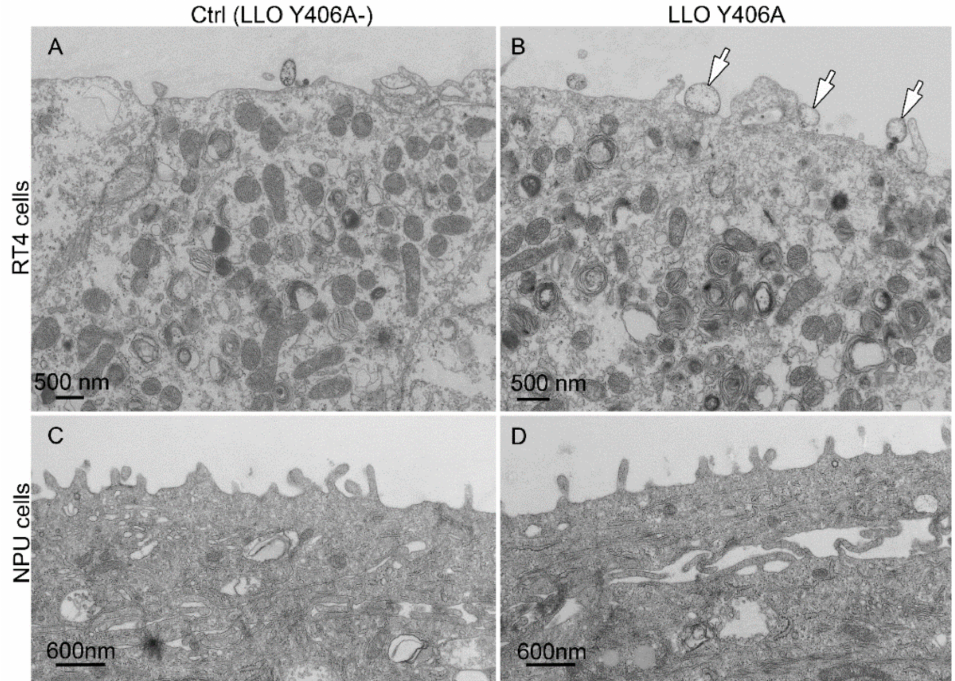
Figure 2. Ultrastructure of urothelial cells after incubation with LLO Y406A. RT4 and normal porcine urothelial (NPU) cells were untreated ( A , C ) or treated with 0.5 µ M LLO Y406A for 2 h ( B , D ). One h after LLO Y406A treatment RT4 cells release extracellular vesicles (arrows, B ), which are not observed in NPU cells ( D